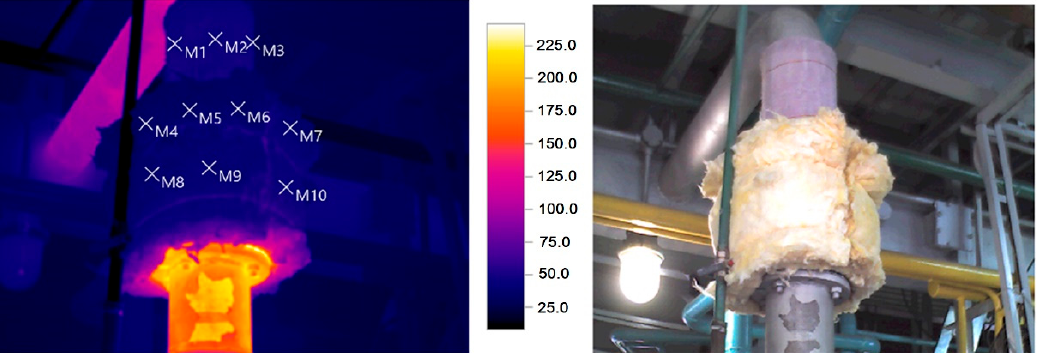
Figure 3. Thermal imaging of an insulated chimney at 300 °C: measurements values (°C) are M1—48.1; M2—46.1; M3—43.9; M4—35.0; M5—34.7; M6—36.2; M7—40.5; M8—37.3; M9—42.0; M10—46.0.